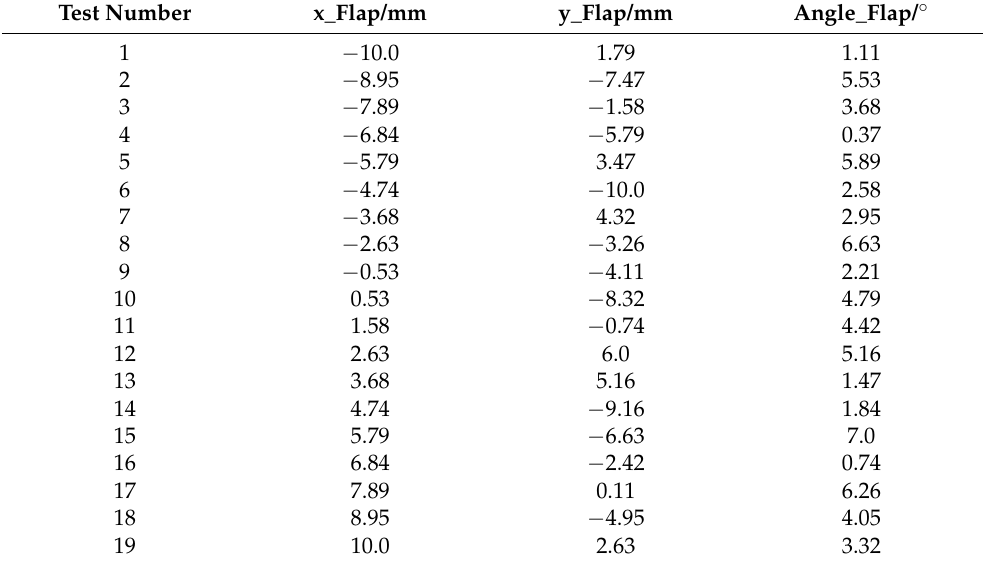
Table 6. Sampling